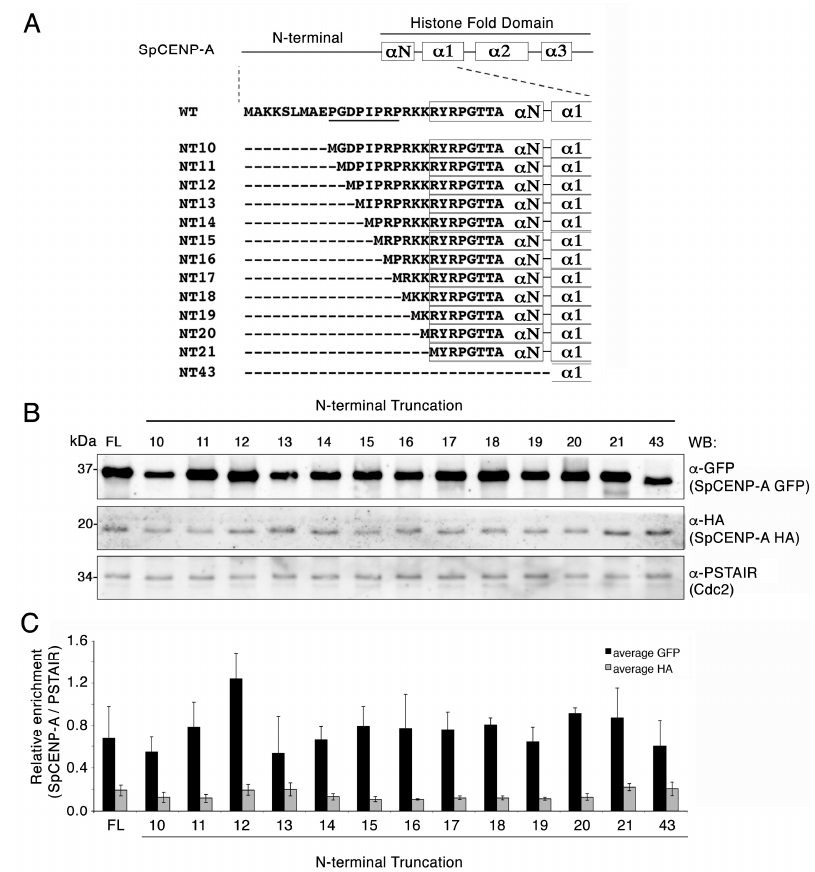
Figure 1. Systematic truncation of the amino acid residues in the Schizosaccharomyces pombe centromeric protein A (SpCENP-A) N -terminus. ( A ) Schematic diagram of SpCENP-A plasmid constructs with N -terminal truncations. NT, N -terminal truncation. Numbering indicates the amino acid residue truncation point relative to the first methionine. ( B ) Western blot examination of the SpCENP-A N -terminal mutant strains bearing a wild-type (WT) HA-tagged endogenous SpCENP-A gene, whereas the overexpressed mutant proteins from the nmt41 promoter on a plasmid were GFP-tagged. Protein levels of SpCENP-A proteins were determined in cells after nmt41 promoter induction by thiamine withdrawal from growth media. Similar levels of proteins were expressed among the exogenous SpCENP-A-GFP NTD ( N -terminal domain) truncation mutants and the endogenous SpCENP-A-HA tagged protein. FL, full-length SpCENP-A protein; PSTAIR (Cdc2), loading control; HA, hemagglutinin, GFP, green fluorescent protein; kDa, kilodalton; WB, western blotting. ( C ) Quantification of the band intensities of the immunoblot shown in ( B ). Graph shows mean values of intensities. Bar, standard deviation. p > 0.05. Student’s t -test. Replicates from three independent experiments (average GFP or